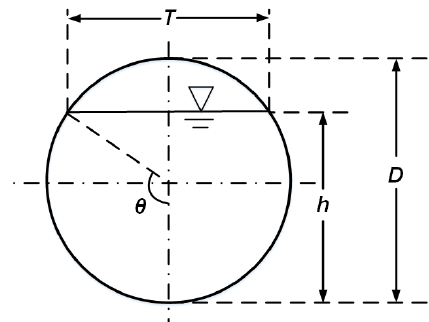
Figure 1. Geometric elements of a circular flow section. The standard design of storm-water sewer pipes allows for partially-full uniform flow (as open-channel flow), with a top width T > 0 at the free h < 1. surface, and a filling ratio y = D